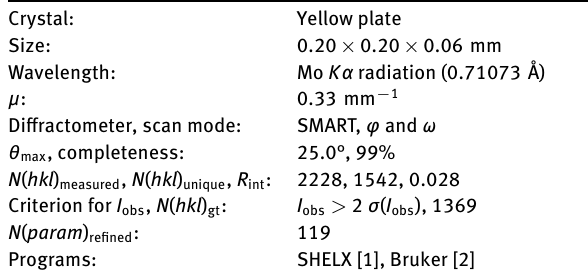
Table 2: Fractional atomic coordinates and isotropic or